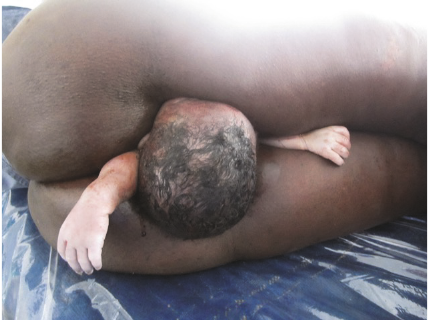
Figure 1: One head and two arms